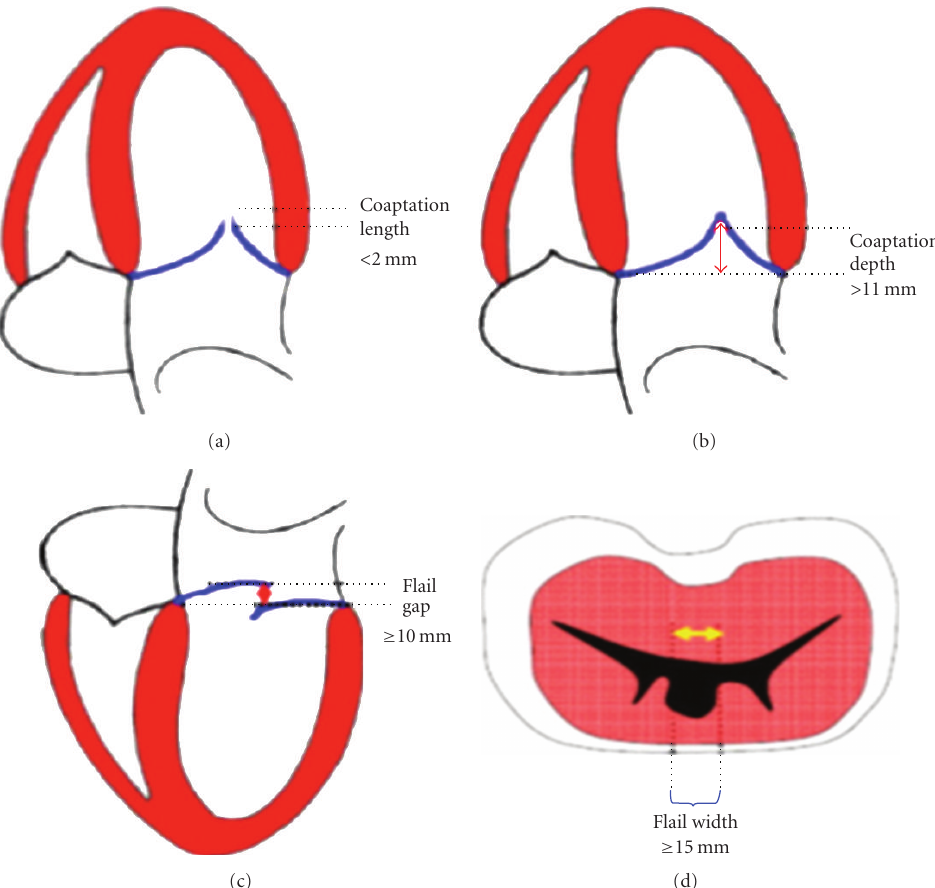
Figure 4: Anatomical exclusion criteria for the percutaneous edge-to-edge